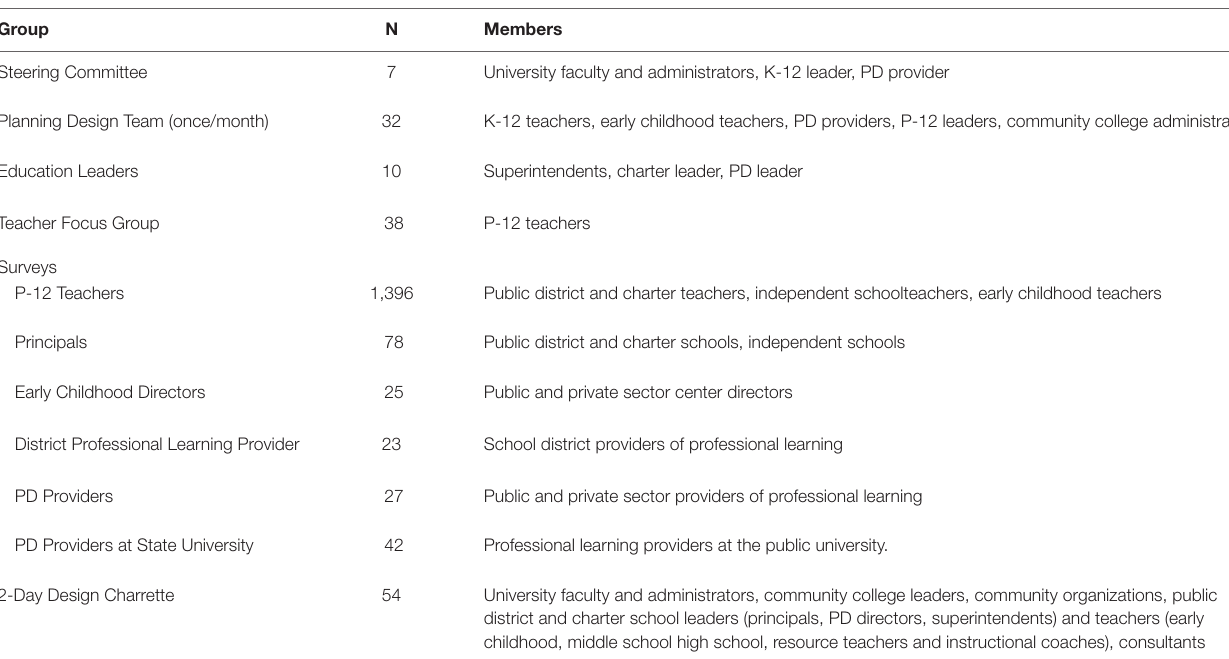
TABLE 1 | Participant